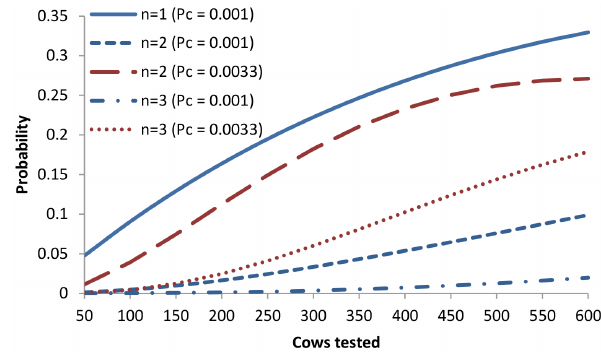
Figure 6. The probability of testing n cows SICCT false positive as a function of herd size. The DEFRA Sp estimate of 0.999 (Pc=0.001) was used; for n=2–3, the 0.9967 Sp estimate by Hartnack and Torgerson [18] (Pc=0.0033) was also applied.